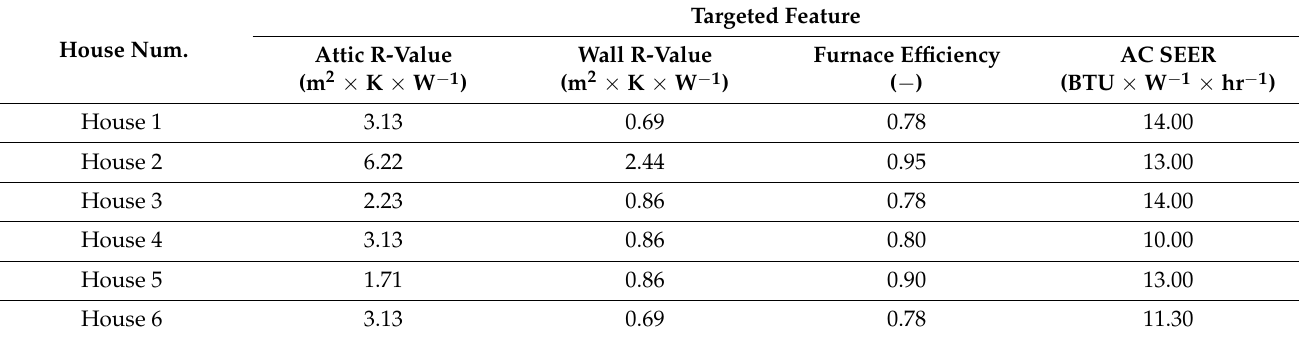
Table 4. Randomly selected test observations.